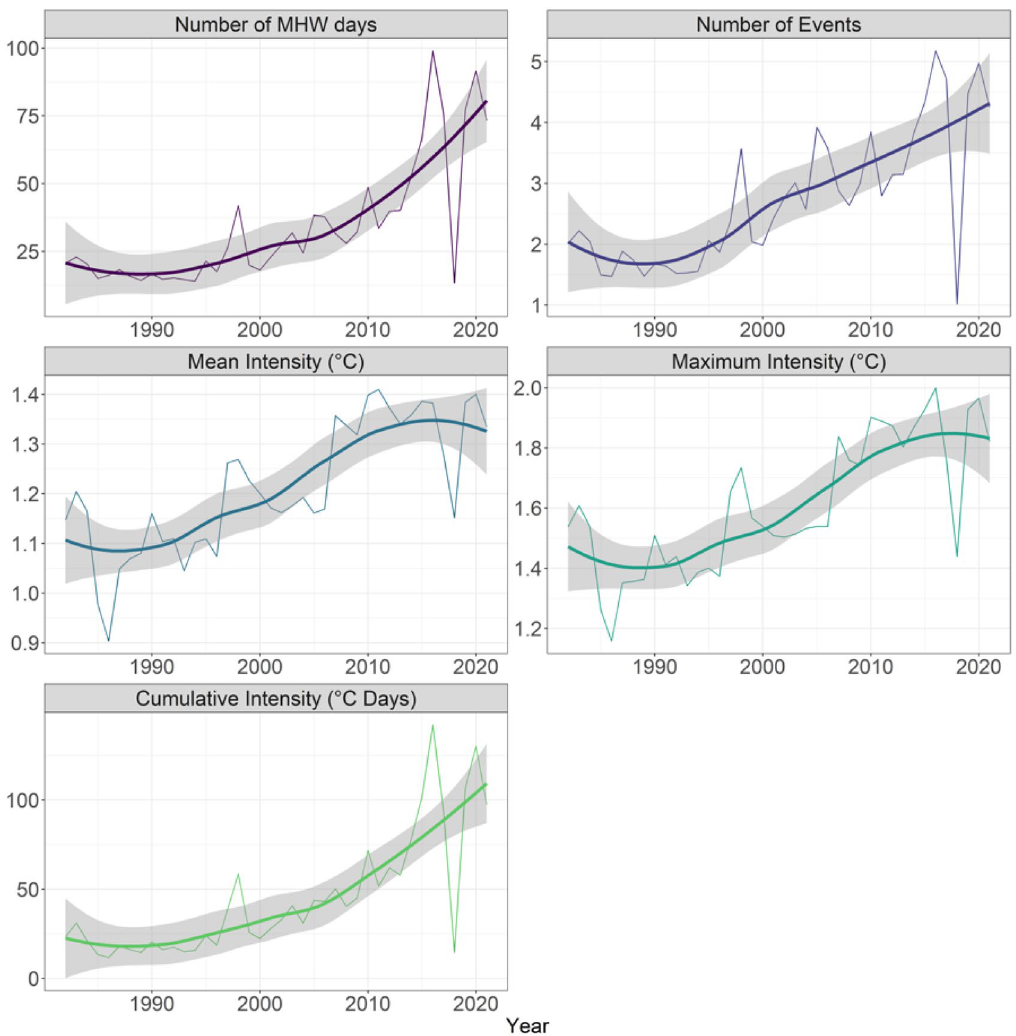
Figure 2. Global trends from January 1982 to December 2021 in the number of yearly-averaged and pixel- averaged marine heatwave days, number of events, mean intensity (°C), maximum intensity (°C) and cumulative intensity (°C days) of marine heatwaves (thin lines). Thick lines show loess smoothing ± 95% confidence intervals. See Table S1 for specific trendlines, p values and break point